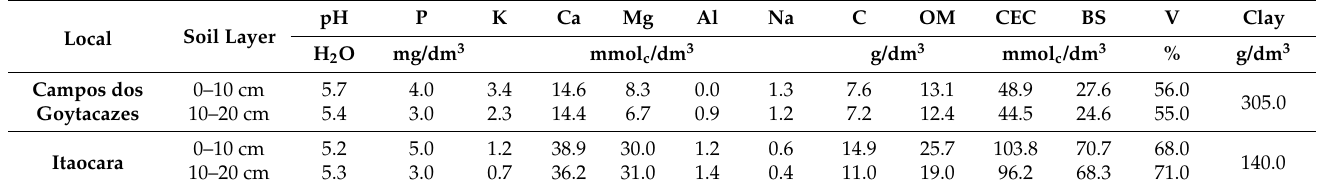
Table 3. Chemical and particle-size analysis of the soil at 0–10 and 10–20 cm depths in Campos dos Goytacazes and